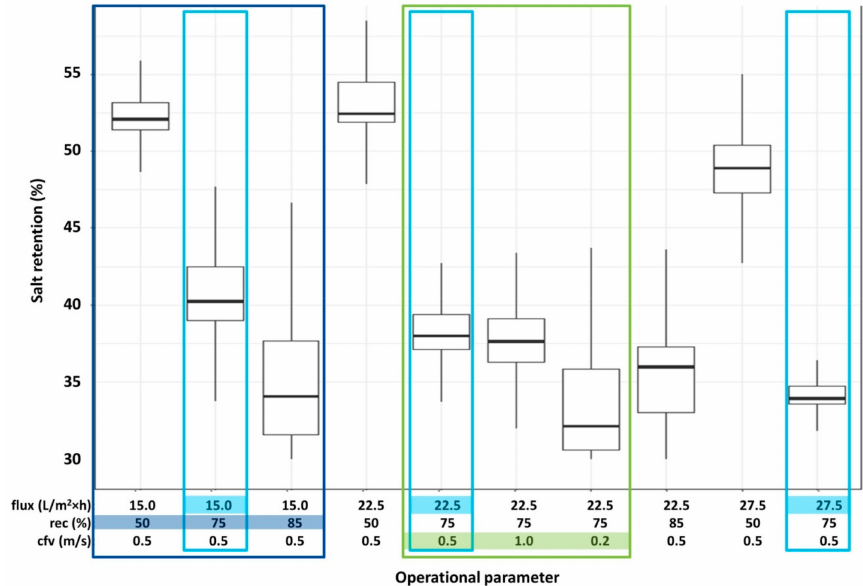
Figure 4. Salt retention (%) for different operational parameter (drinking water as feed source), light blue: increase of flux at constant rec and cfv, dark blue: increase of recovery at constant flux and cfv, green: increase of cfv at constant flux and